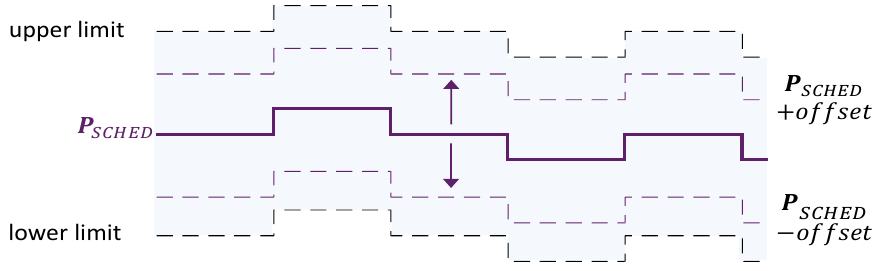
Figure 19. The power injection